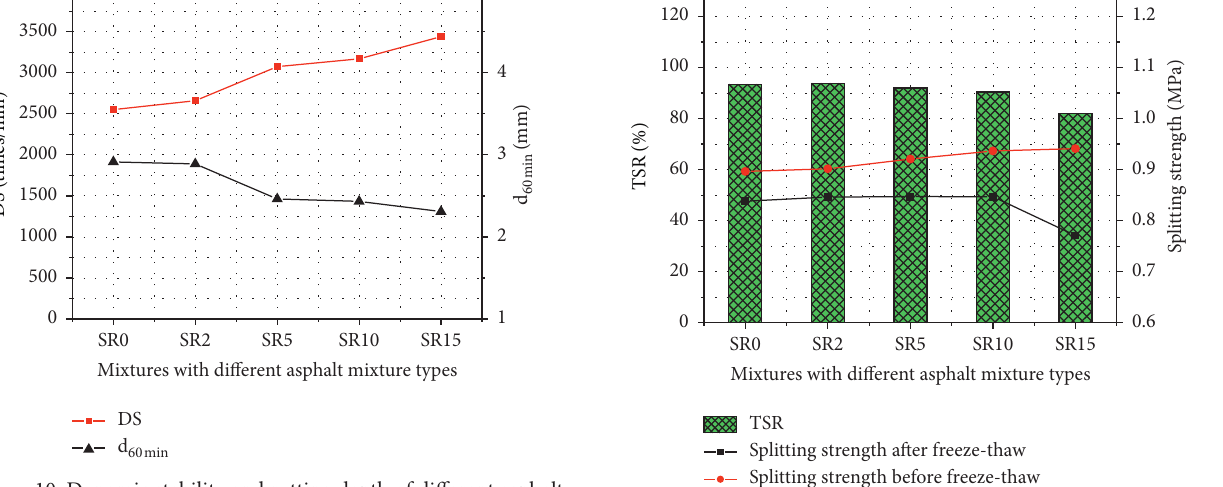
Figure 12: Freeze-thaw splitting test results of different asphalt mixtures.